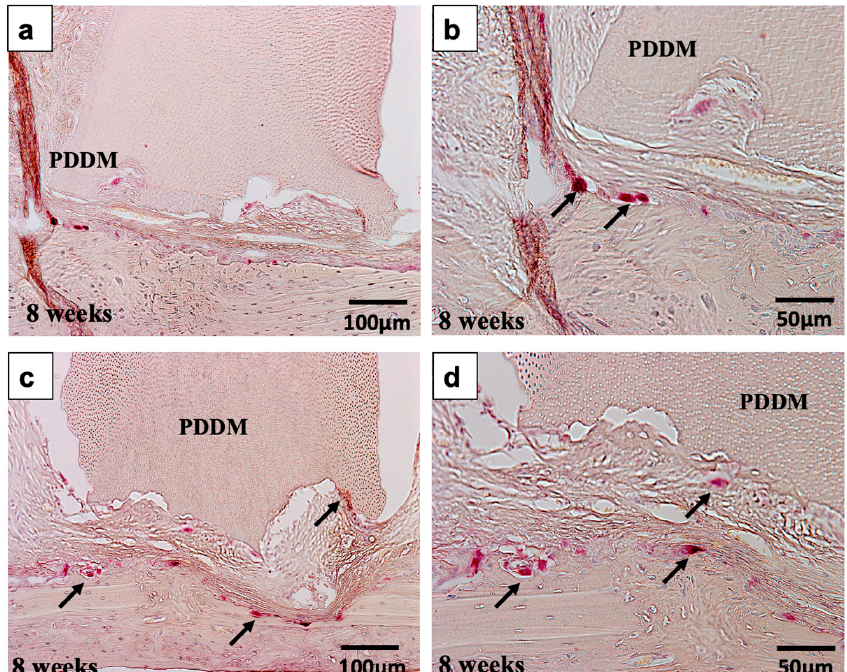
Figure 10. TRAP-staining images of scratched skull without periosteum at 8 weeks. Sections ( a , b ) and ( c , d ) were derived from different blocks. TRAP-positive cells (arrow) appeared predominantly nearby skull, compared with sides of PDDM block. PDDM: Partially demineralized dentin matrix.